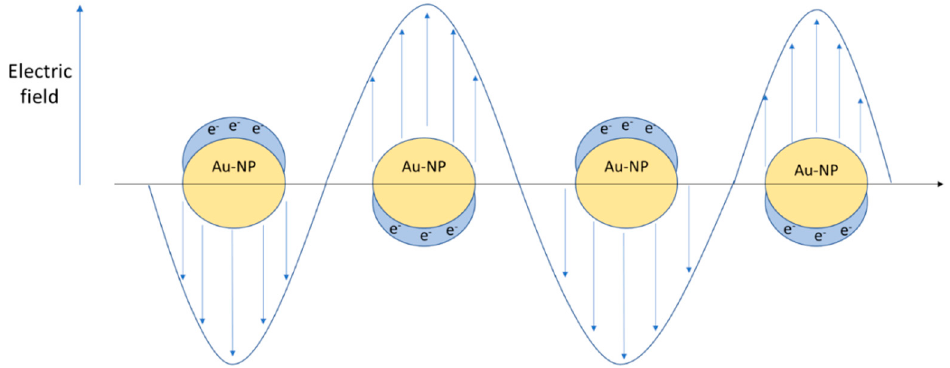
Figure 8. Localized surface plasmon resonance (LSPR) induced by external radiation.